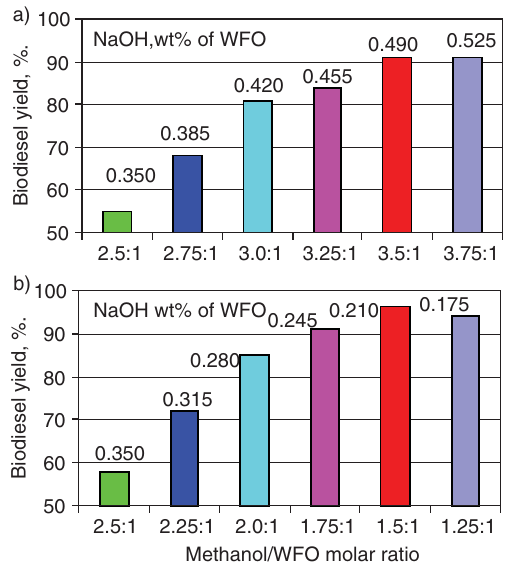
Fig. 3. The effect of using a two-step method on biodiesel yield with different combinations of methanol to WFO molar ratio and NaOH